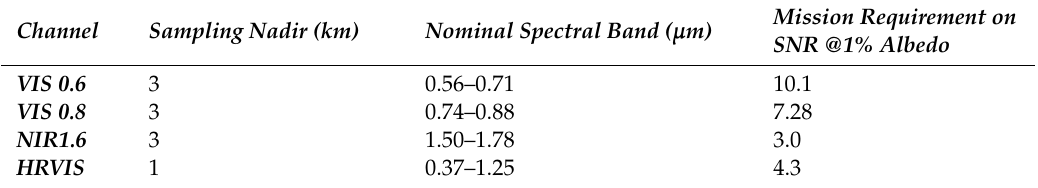
Table 2. Spatial and spectral characteristics of the four Spinning Enhanced Visible Infra-Red Imager (SEVIRI) visible (VIS) and near infrared (NIR) channels. HRVIS: high-resolution